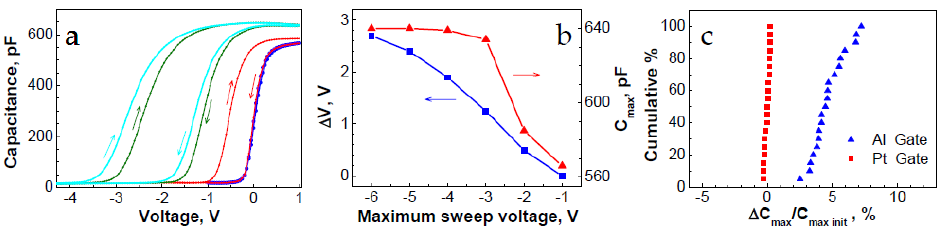
Figure 6. ( a ) Capacitance – voltage characteristics of Al/GO/n-Si MIS structures measured from accumulation at +1 V to depletion at negative bias up to − 1 V (blue), − 2 V (red), − 5 V (green) and − 6 V (cyan)Arrows show direction of the voltage sweep; ( b ) C – V curve shift along the voltage axis during sweep from accumulation to depletion (blue), and maximum capacitance (red) after sweep at various negative voltages as a function of maximum negative sweep voltage; ( c ) cumulative plot of the change of accumulation capacitance measured on MIS structures with Al and Pt gates.